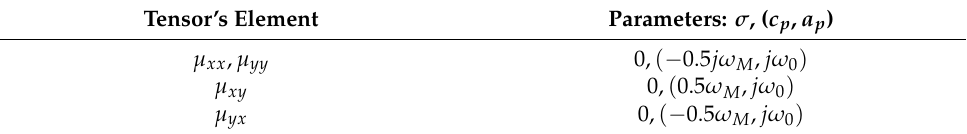
Table 3. CCPR parameters for lossy ferrites.